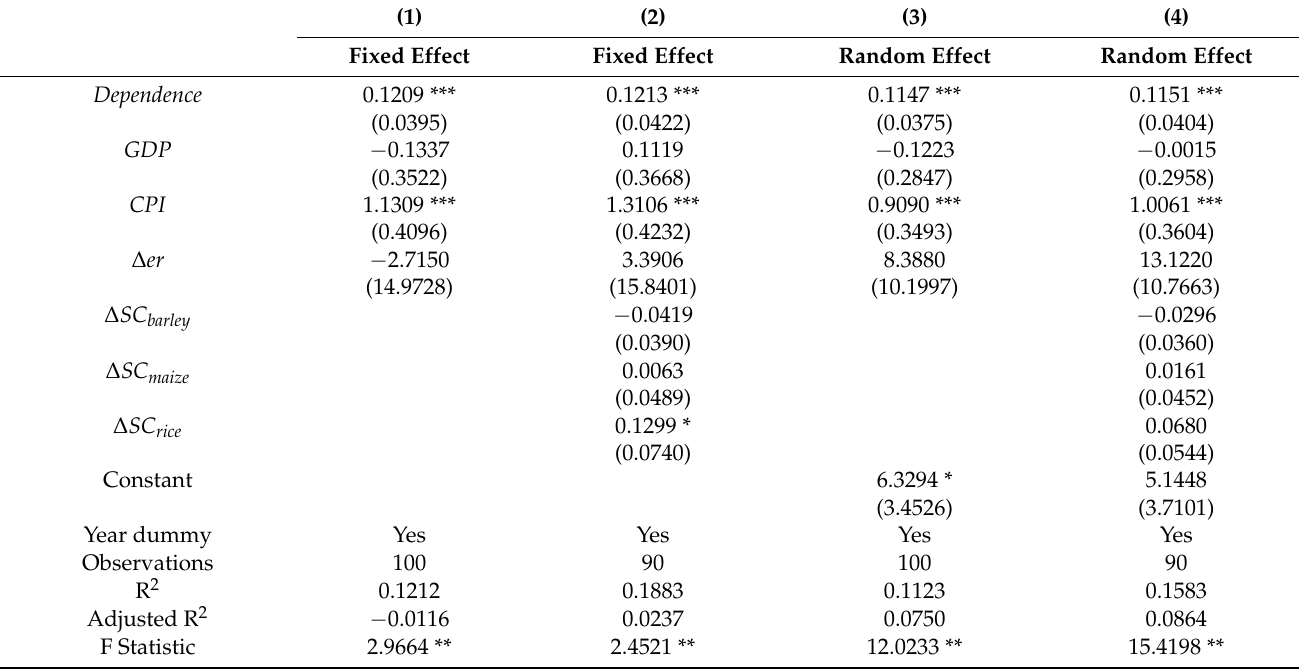
Table 8. Results of panel data